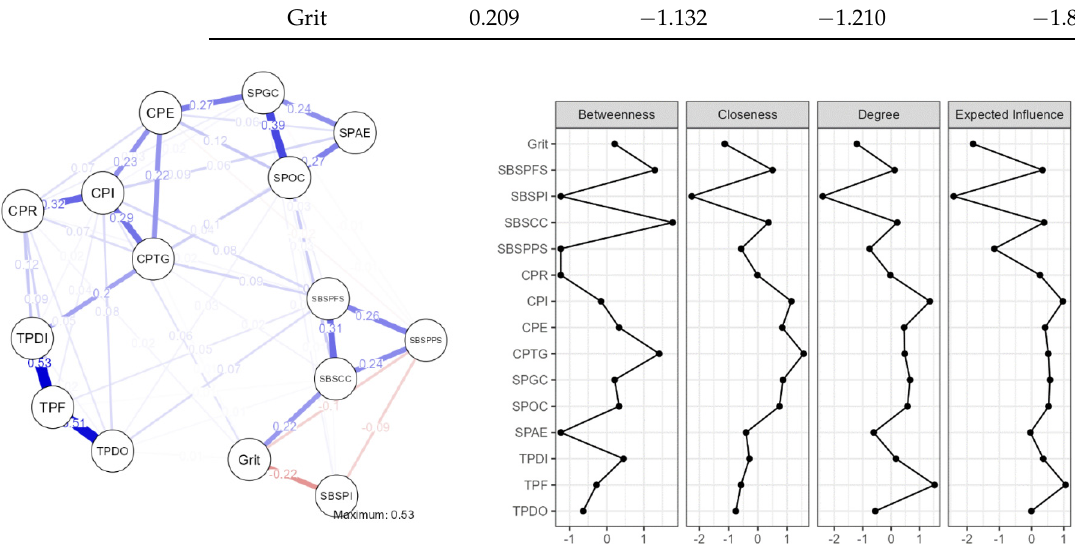
Figure 2. Network analysis and centrality plot.